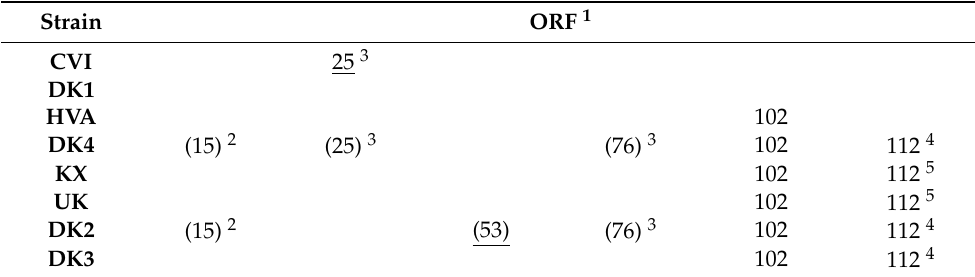
Table 2. Gene disruptions identified in AngHV-1 isolates relative to reference strain